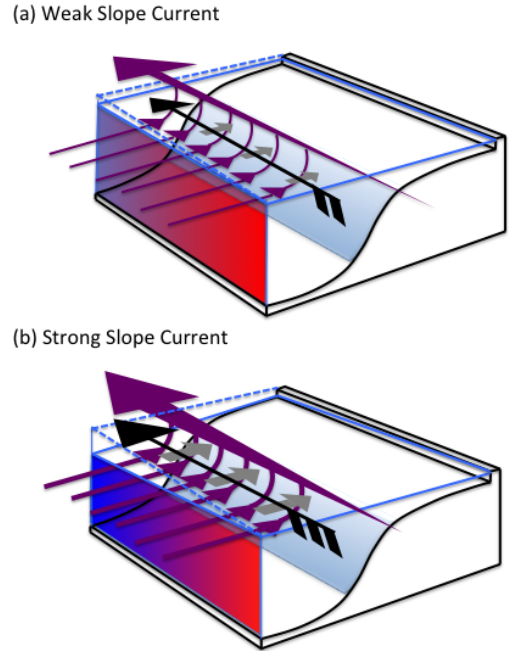
Figure 16. Schematics showing density gradients (shaded red to pale or dark blue), eastward geostrophic inflow, wind forcing (black alongshore arrow), Ekman transports (grey onshore arrows) and sea surface slopes at an idealized eastern boundary, associated with (a) weak and (b) strong Slope Current